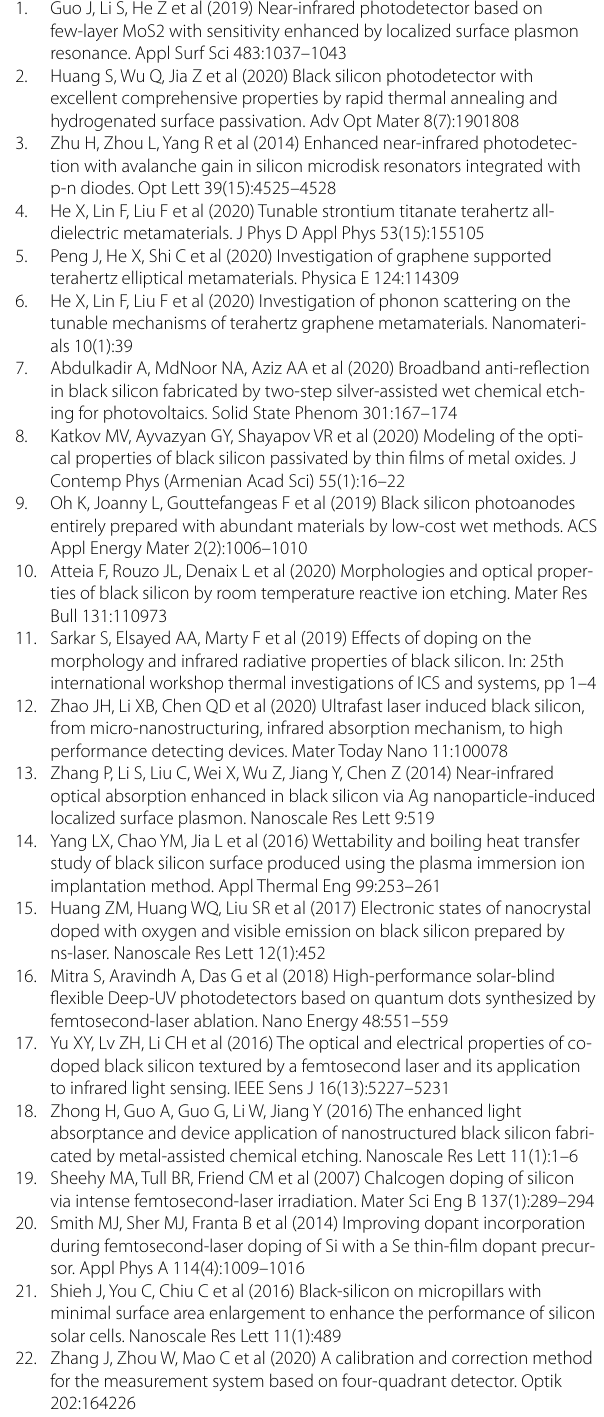
Table 3 Test results of dark current Quadrant Dark current